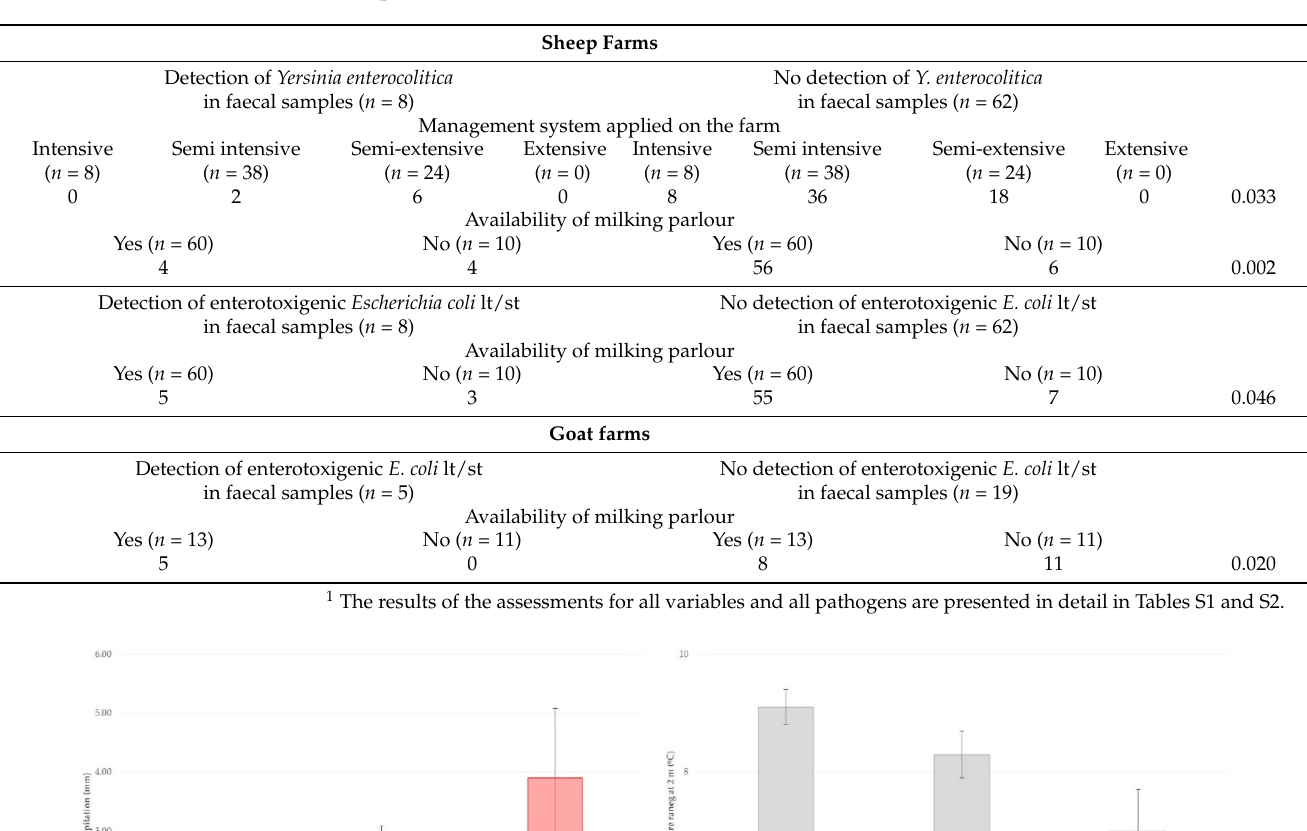
Table 2. Results of significant associations (univariable analysis) of management-related variables with detection of specific gastrointestinal pathogens in faecal samples from sheep ( n = 70) or goat ( n = 24) farms in Greece, as found by means of the BioFire ® FilmArray ® Gastrointestinal (GI) Panel multiplex-PCR 1 .